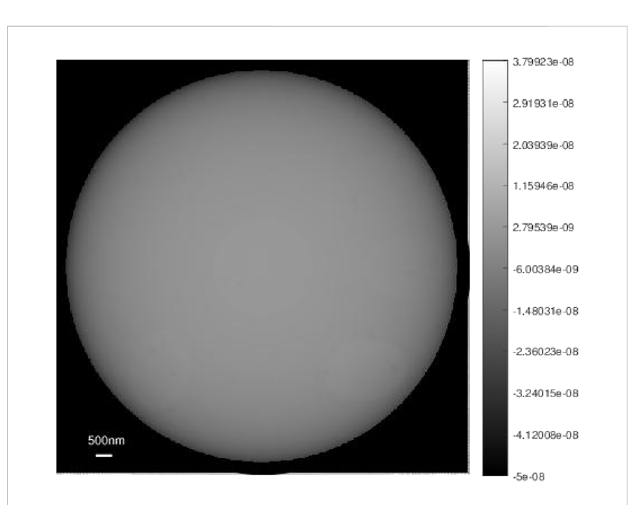
FIGURE 12 The inversion result using LSM for noisy data with noise-level